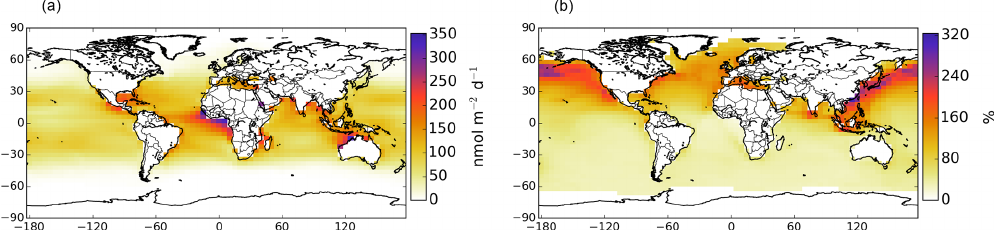
Figure 1. Inorganic emission flux (HOI, I 2 ) in the preindustrial (a) and percent change from the preindustrial to present day ( ( PD − PI )/ PI · 100) (b) .